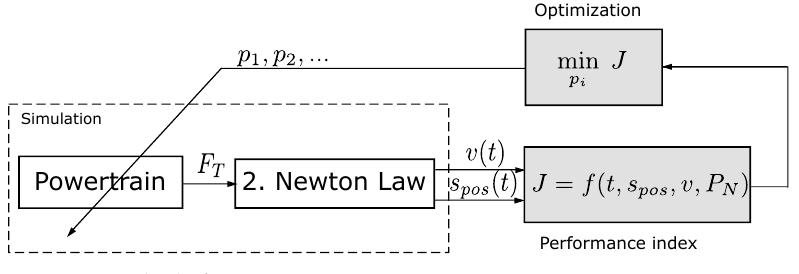
Figure 1. Method of powertrain optimization. The powertrain parameters that are optimized are p i , performance index J can be function of time t , position s pos , speed v or power of the traction motor P N . The traction force F T on wheels is the output of the